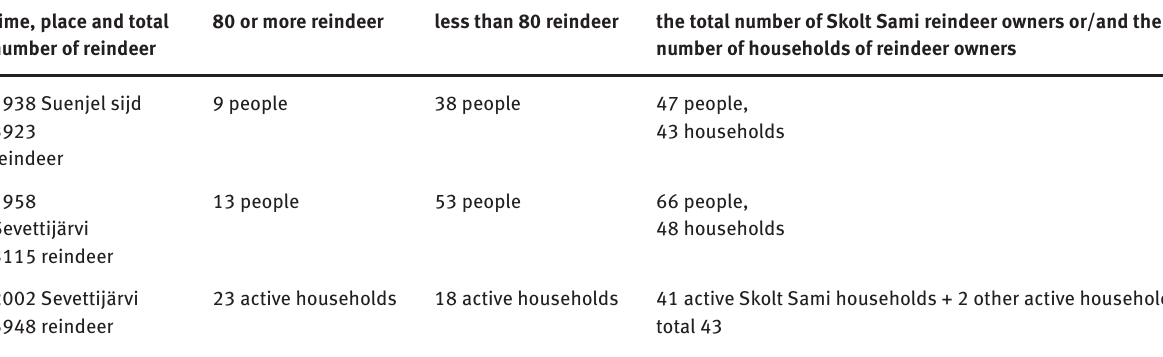
Table 1: The division of Skolt Sami reindeer ownership in different times, first in Suenjel sijd and then in Sevettijärvi area (sources: Nickul 1948, Pelto 1962, Poromies 2003, Sverloff 2003, Itkonen 2012, Itkonen 2018).